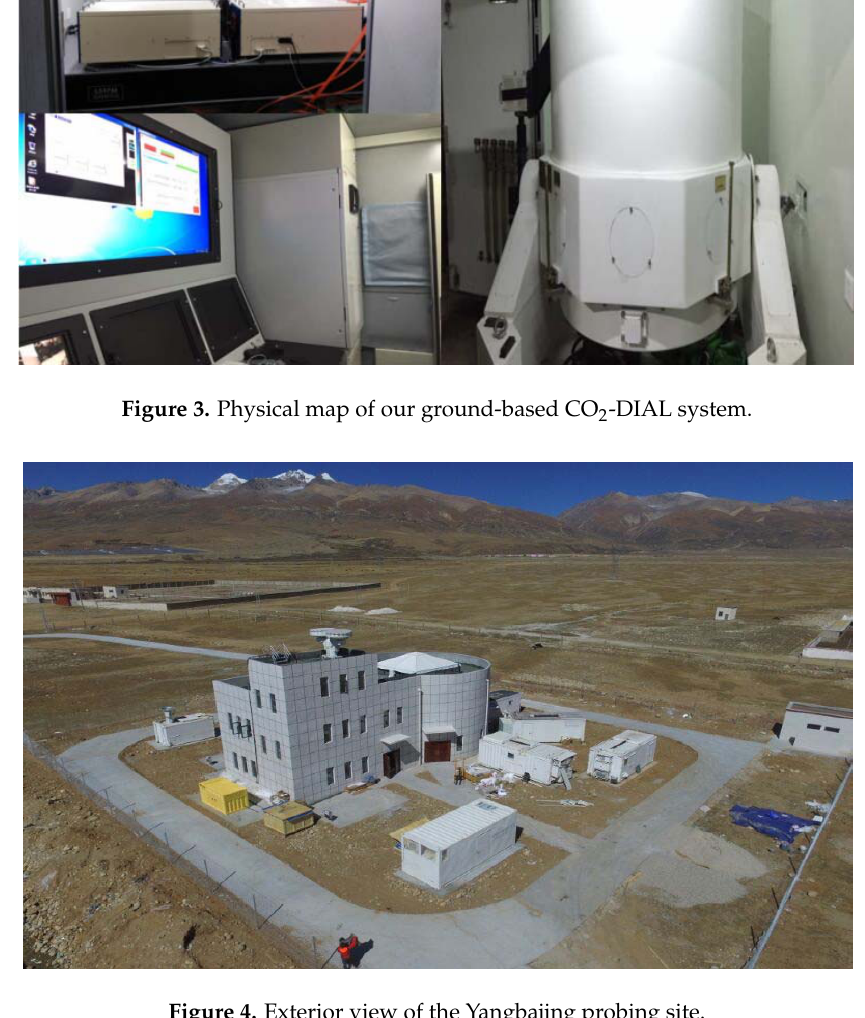
Figure 4. Exterior view of the Yangbajing probing site.